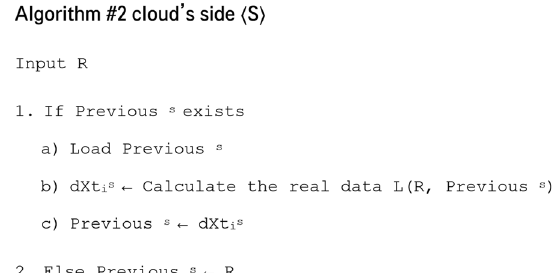
Fig. 2 Operation algorithm at the cloud